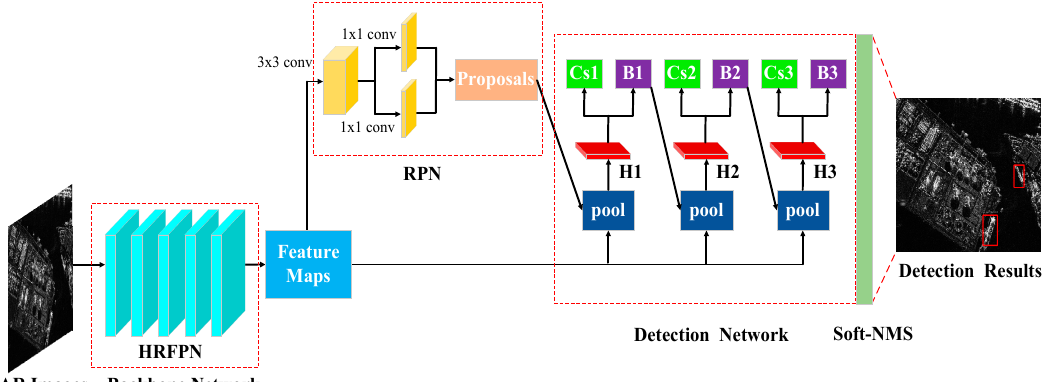
Figure 3. The architecture of the HR-SDNet method. Where “HRFPN” represents a feature extraction network; “pool” indicates the region-wise feature extraction; “H” denotes the detection head; “B” denotes the bounding box; “Cs” represents the classification, and “RPN” represents the proposals in all architectures.